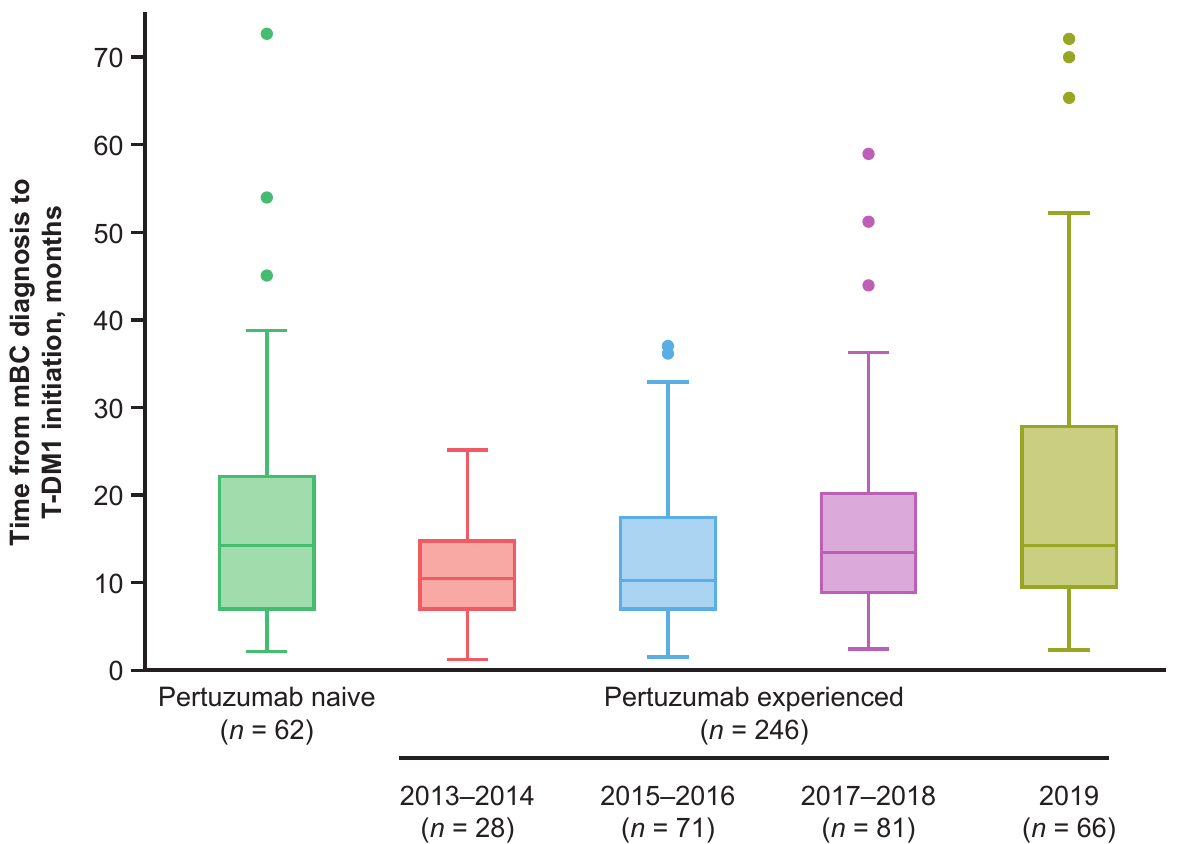
Figure 3. Time from diagnosis of mBC to initiation of T-DM1 in the secondary cohort. The secondary cohort consisted of patients who initiated T-DM1 in the second-line setting following treatment with trastuzumab ± pertuzumab. The dots denote outliers, which were calculated per Tukey’s method (Q3 + [1.5 × IQR]). From bottom to top, the bars denote the minimum, Q1, median, Q3, and maximum (once outliers have been removed) values, respectively. IQR = interquartile range; mBC = metastatic breast cancer; Q1 = first quartile; Q3 = third quartile; T-DM1 = trastuzumab